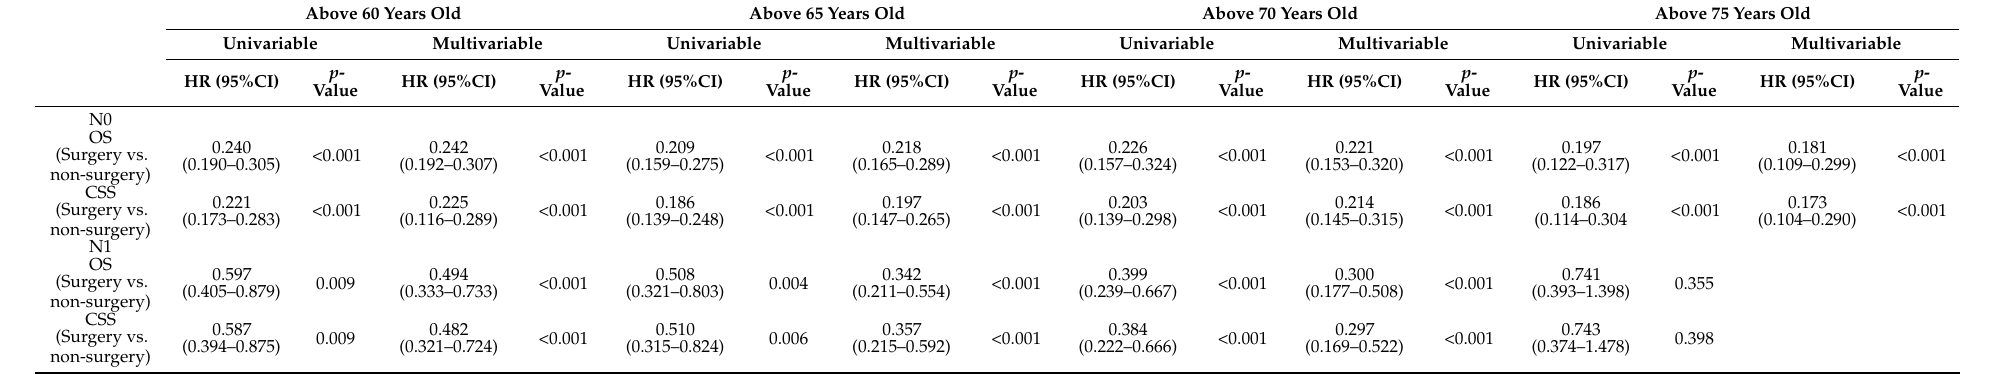
Table 4. Estimated 3-year and 5-year survival rates of surgery and non-surgery groups for N0 and N1 ICC patients in different age